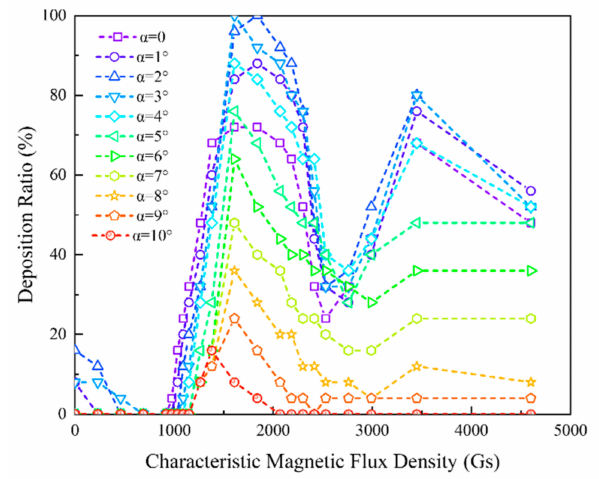
Figure 13. Relationship between deposition ratio and characteristic magnetic flux density for ions with various emission